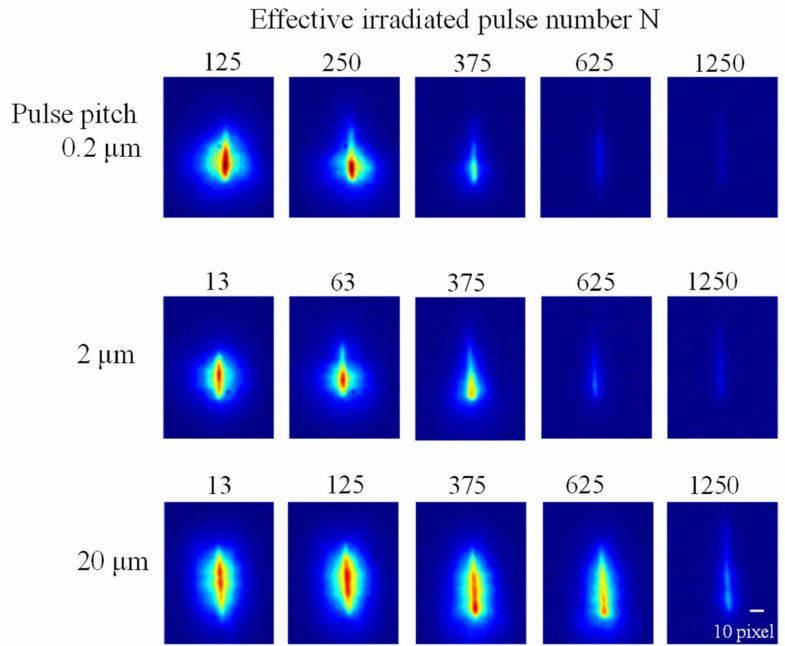
Figure 9. Evolution of plasma intensity distribution in PLG processing at different pulse pitches.